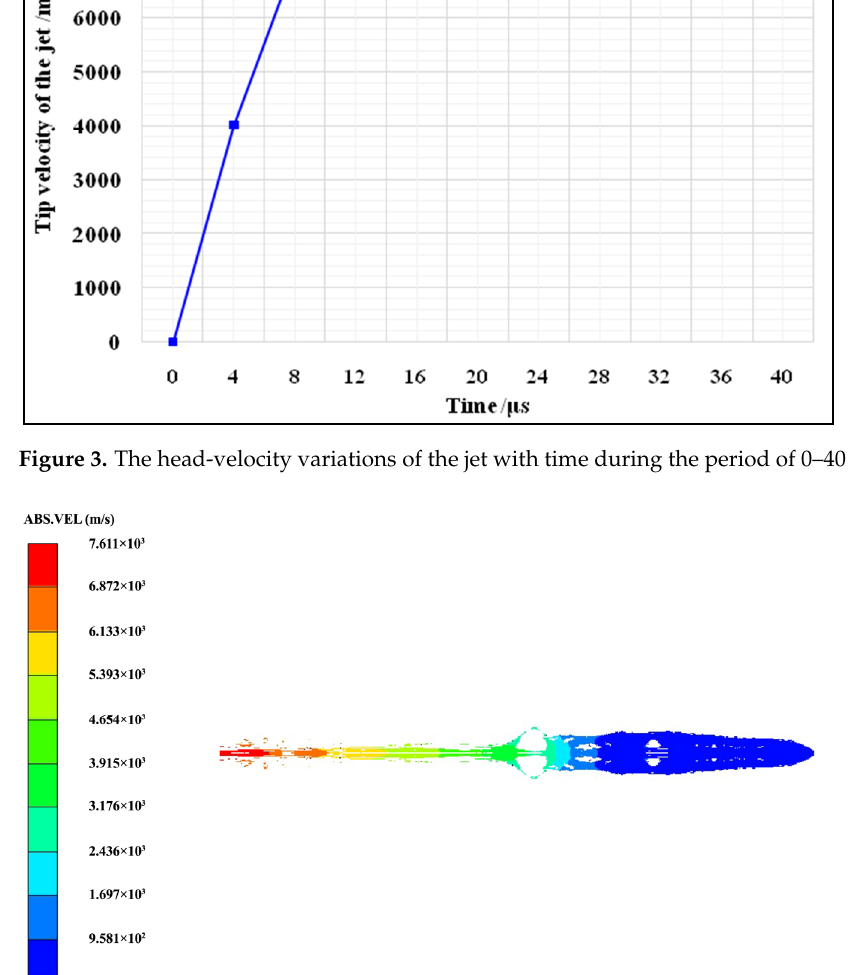
Figure 4. The cloud diagram of the jet’s velocity distribution at the moment of 30 μs.